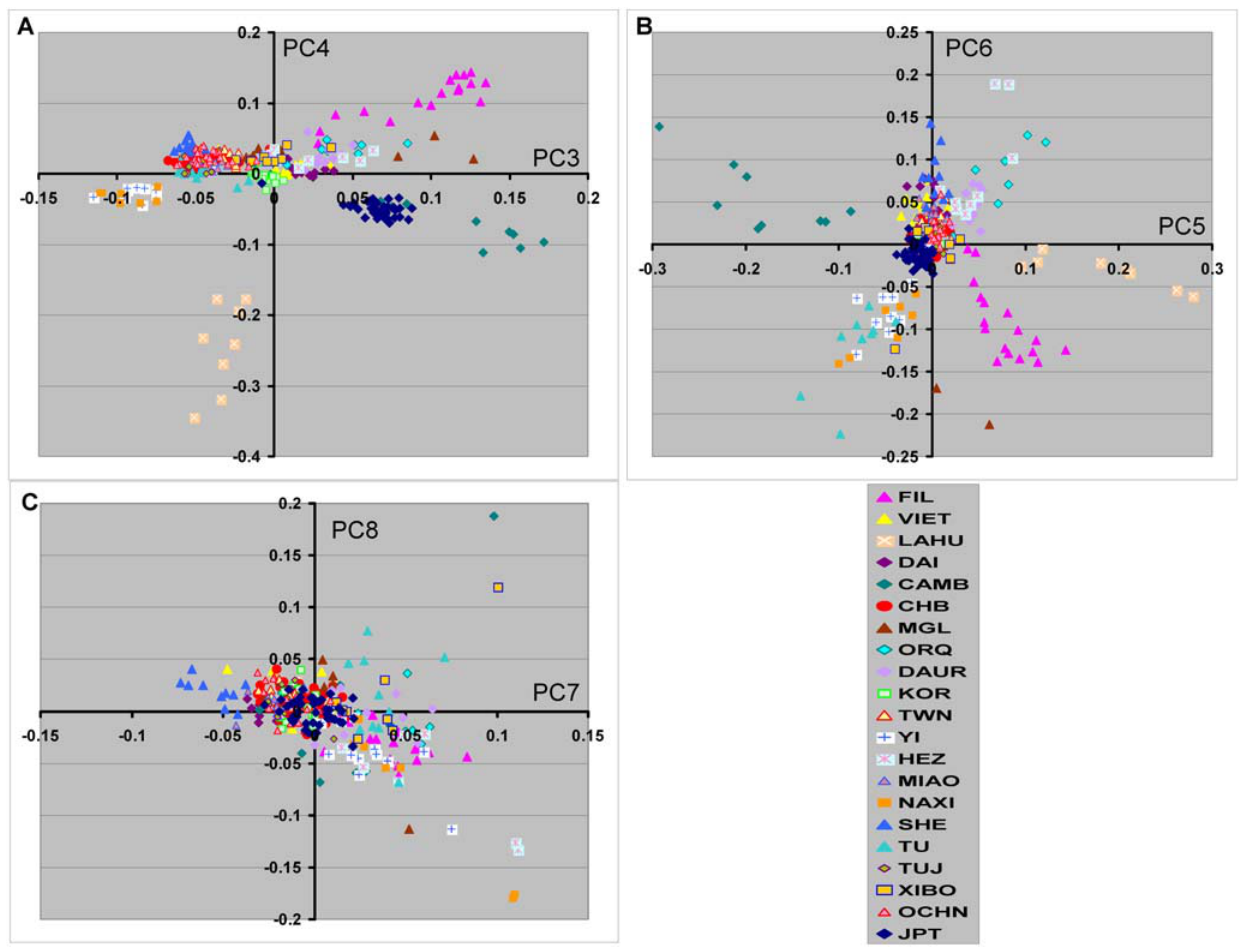
Figure 2. Graphic representation of additional principal components (PCs 3–8) in a diverse set of subjects of East Asian Descent. Color key shows groups as defined in Fig 1 . A , PC3 and PC4. B , PC5 and PC6. C , PC7 and PC8.